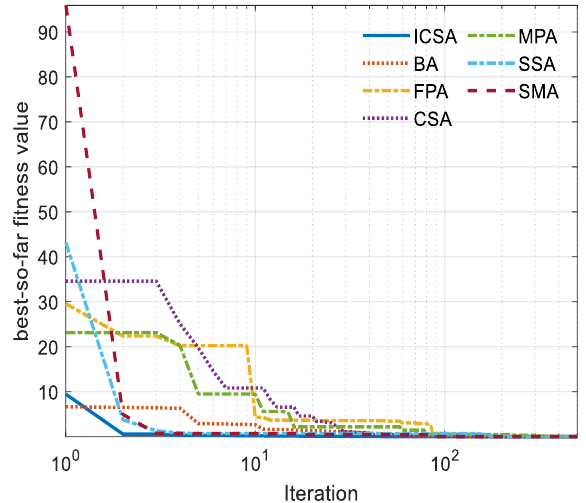
Figure 12. Convergence curve for F12.